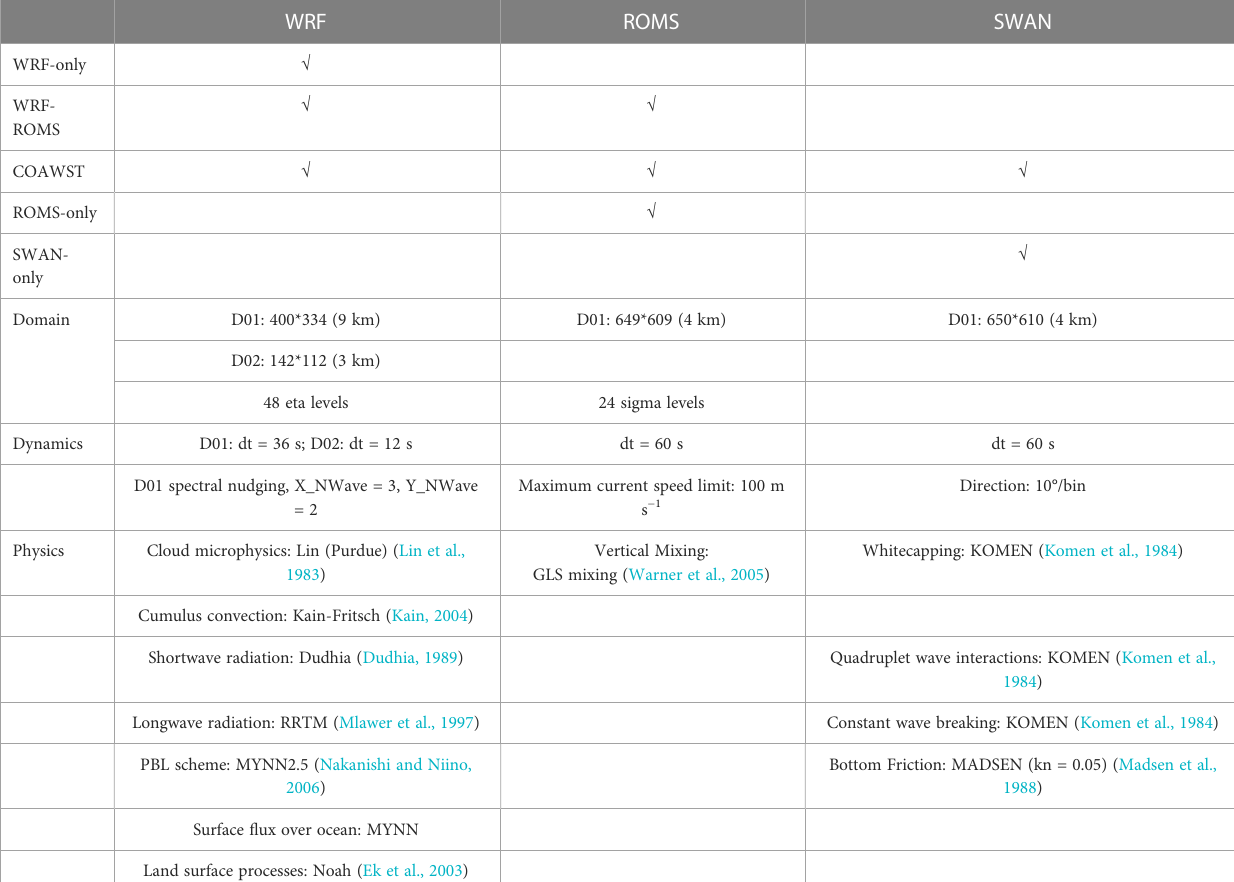
TABLE 1 Main experimental settings and summary of con fi gurations across the three component models. WRF ROMS SWAN